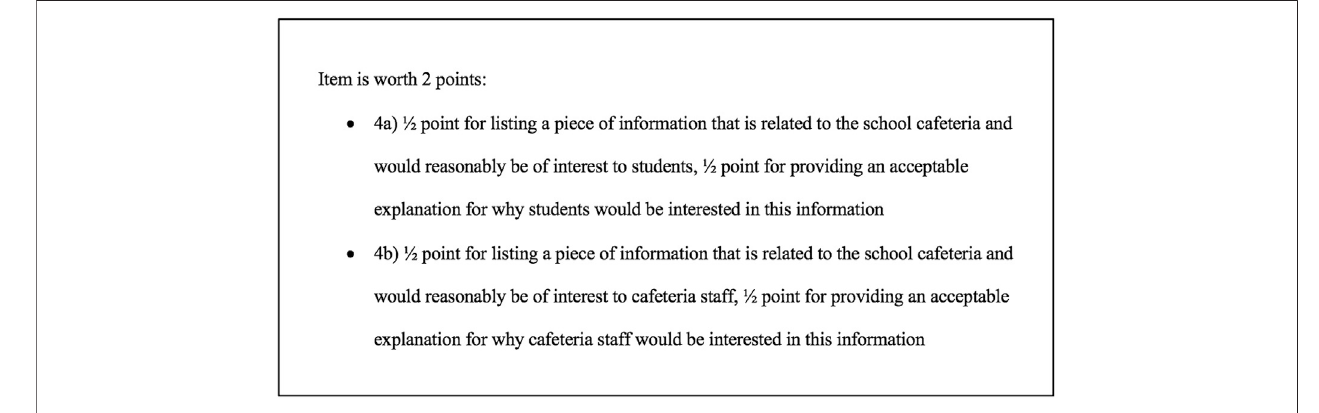
FIGURE 6 | Scoring rubric for unit 2 assessment, item 4.